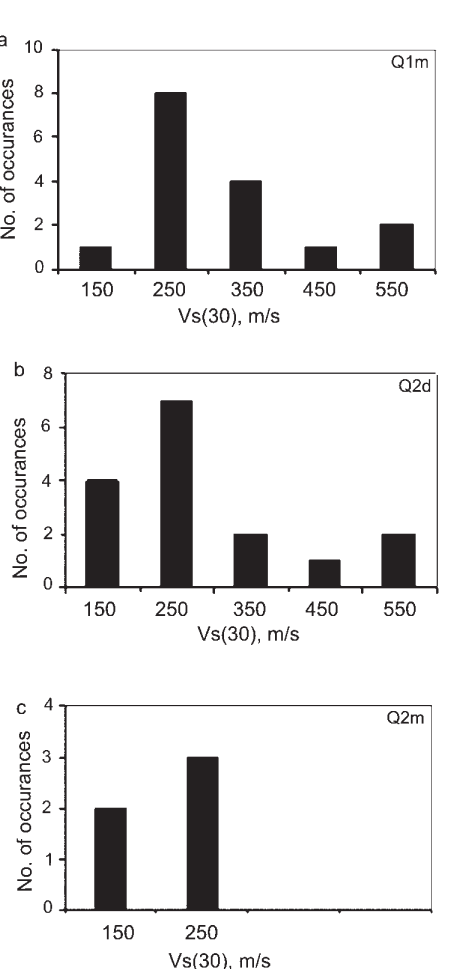
Fig. 10a-c. Histogram of Vs(30) for (a) unit Q1m, (b) unit Q2d and (c) unit